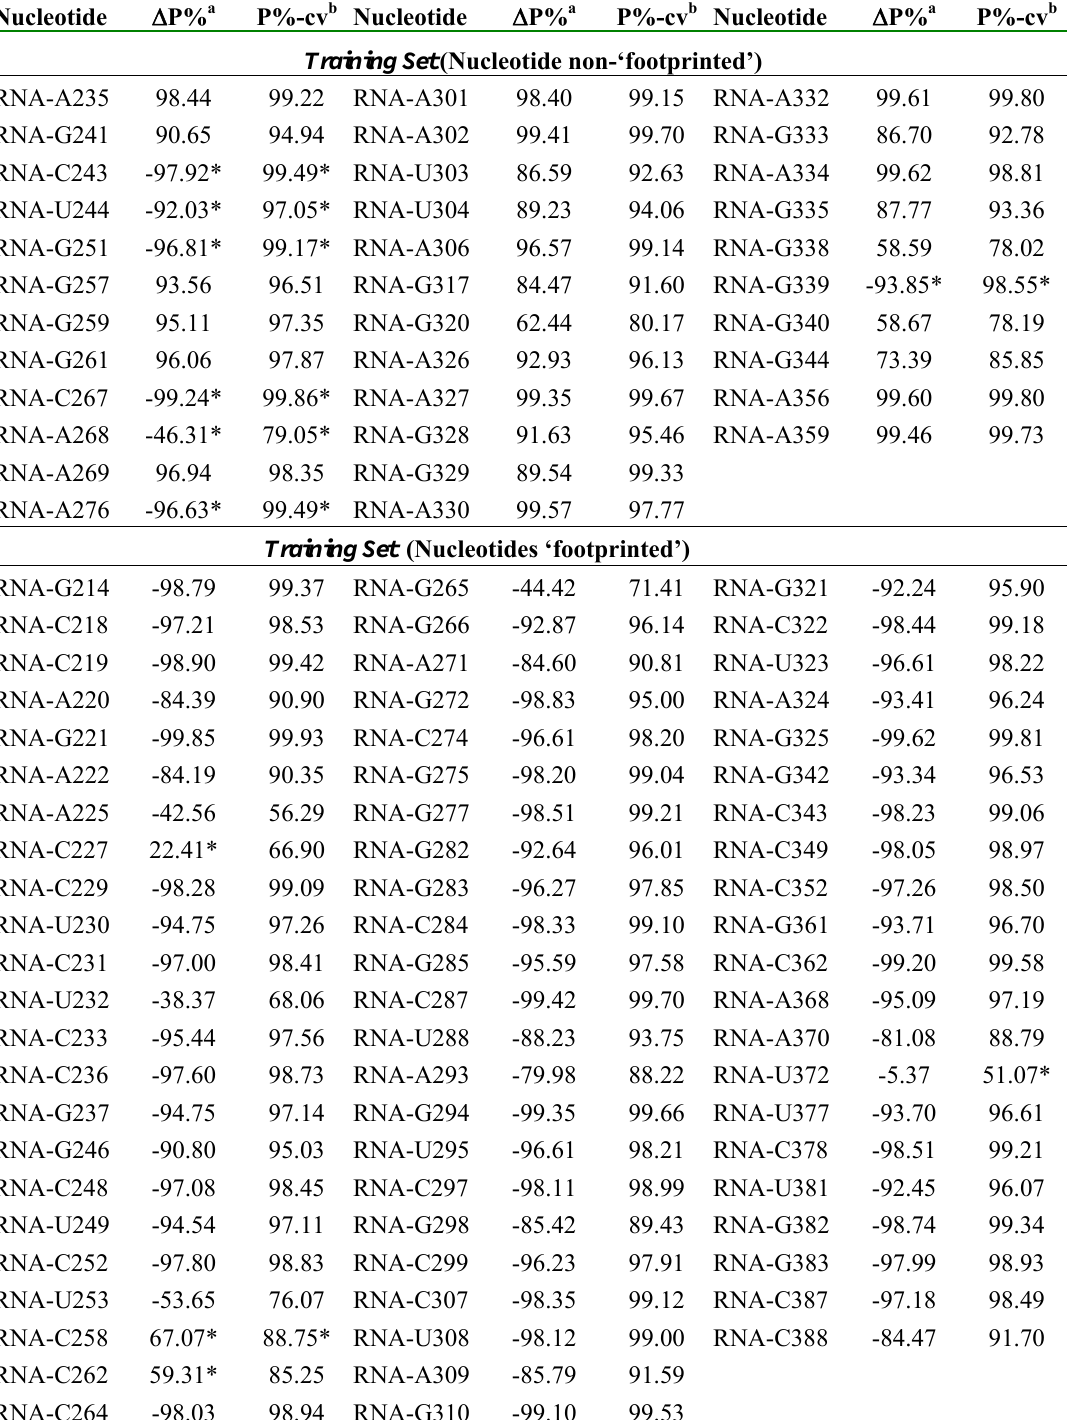
Table 3. Training Set Classification